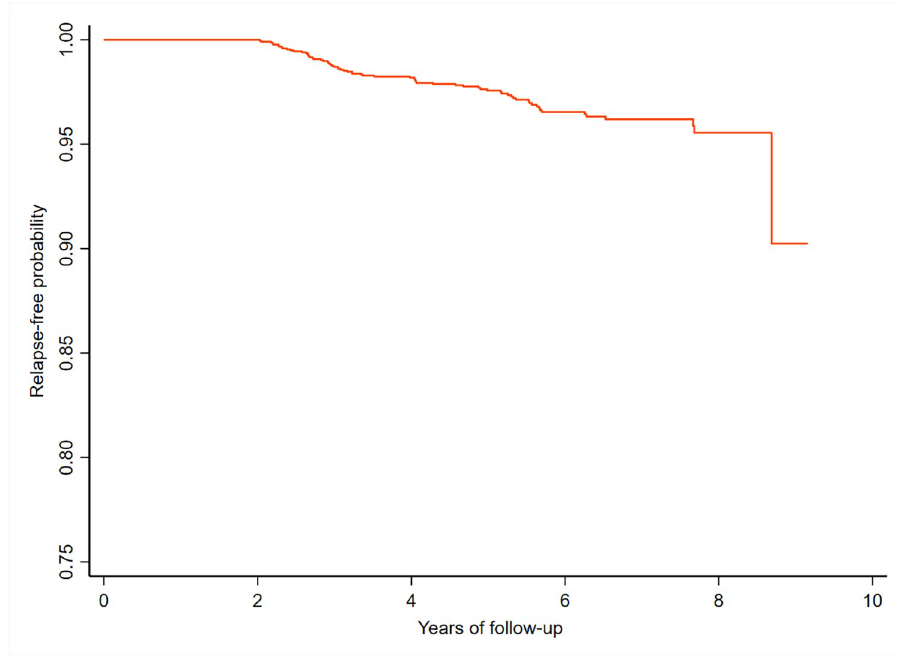
Fig 2. Survival curve by Kaplan Meier method–Relapse free probability among RFT patients: Relapse and deformity among patients released from National Leprosy Eradication Programme of India: A cohort study from four districts in South India.